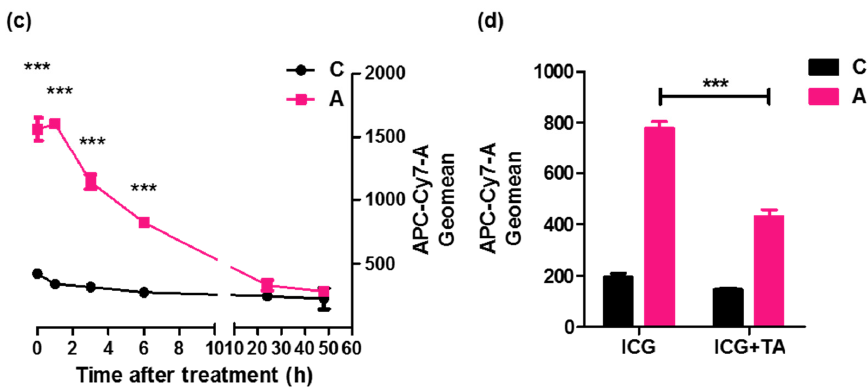
Figure 3. The pharmacokinetics of ICG in cells expressing ASBT. ICG intensity detected through flow cytometry ( a ) for treatment with different ICG doses, ( b ) after cotreatment with taurocholate, and ( c ) after ICG treatment to observe the decline. ( d ) The quantification from panel (B). C: control cells. A: cells expressing ASBT. U: untreated. TA: taurocholate. Error bars show the SEM, where *** p < 0.001.